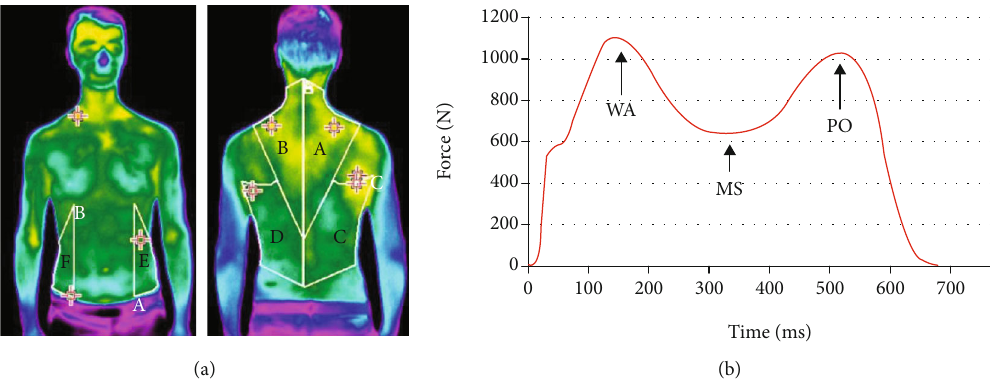
Figure 2: (a) Exemplary thermal image of a volunteer with muscles marked in the software: A/B — trapezius (right/left), C/D — latissimus dorsi (right/left), and E/F — obliquus abdominis (left/right). (b) Chosen results of ground reaction type combination. Three ground reaction forces were consid- ered (see Figure 2(b)): maximal weight acceptance force (WA), force in midstance (MS) (local minimum), and maxi- mal force in push-o ff gait phase (PO).